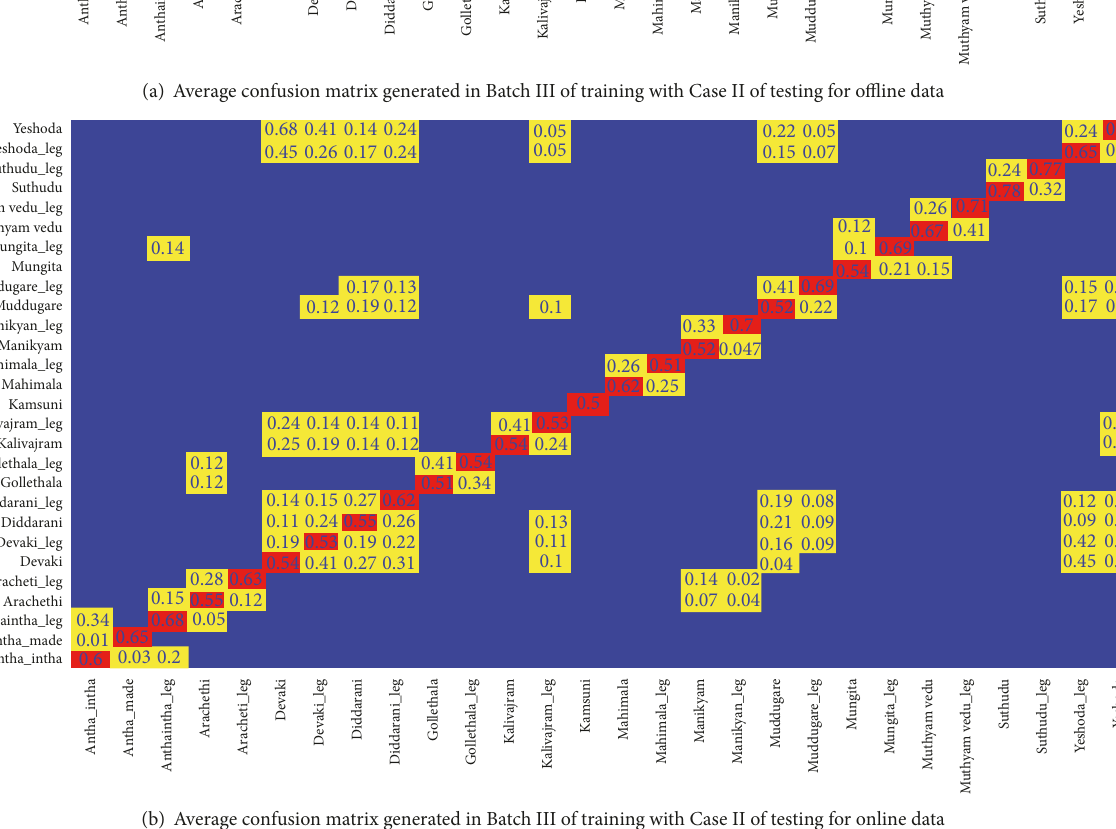
(b) Average confusion matrix generated in Batch III of training with Case II of testing for online data Figure 7: Average confusion matrices generated for Indian classical dance